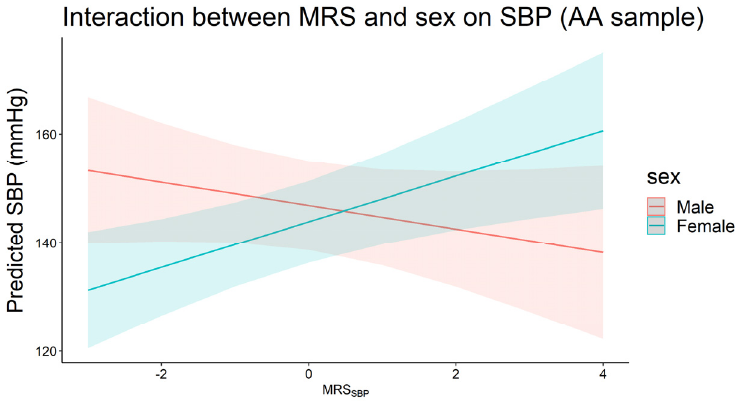
Figure 3. Plot of predicted systolic blood pressure by MRS SBP for males ( n = 149) and females ( n = 288) in the African ancestry sample ( p interaction < 0.05).